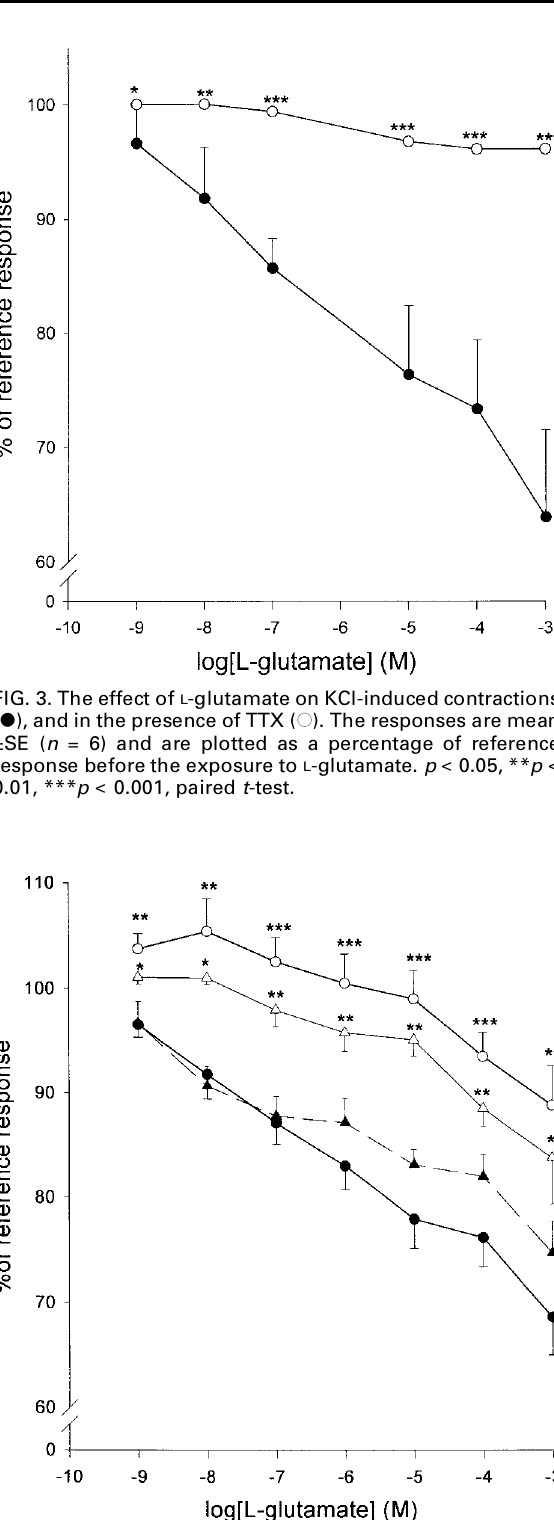
FIG. 4. The effect of L -glutamate on KCl-induced contractions ( d ), and in the presence of methylene blue ( s ), L -NAME ( m ) and indomethacin ( n ). The responses are mean ±SE; n = 11 for experiments with L -glutamate, n = 7 for experiments in the presence of methylene blue, n = 5 for experiments in the presence of L -NAME, and n = 6 for experiments in the presence of indomethacin. The responses are plotted as a percentage of the reference response before the exposure to L -glutamate. * p < 0.05, ** p < 0.01 and *** p < 0.001, unpaired t -test.